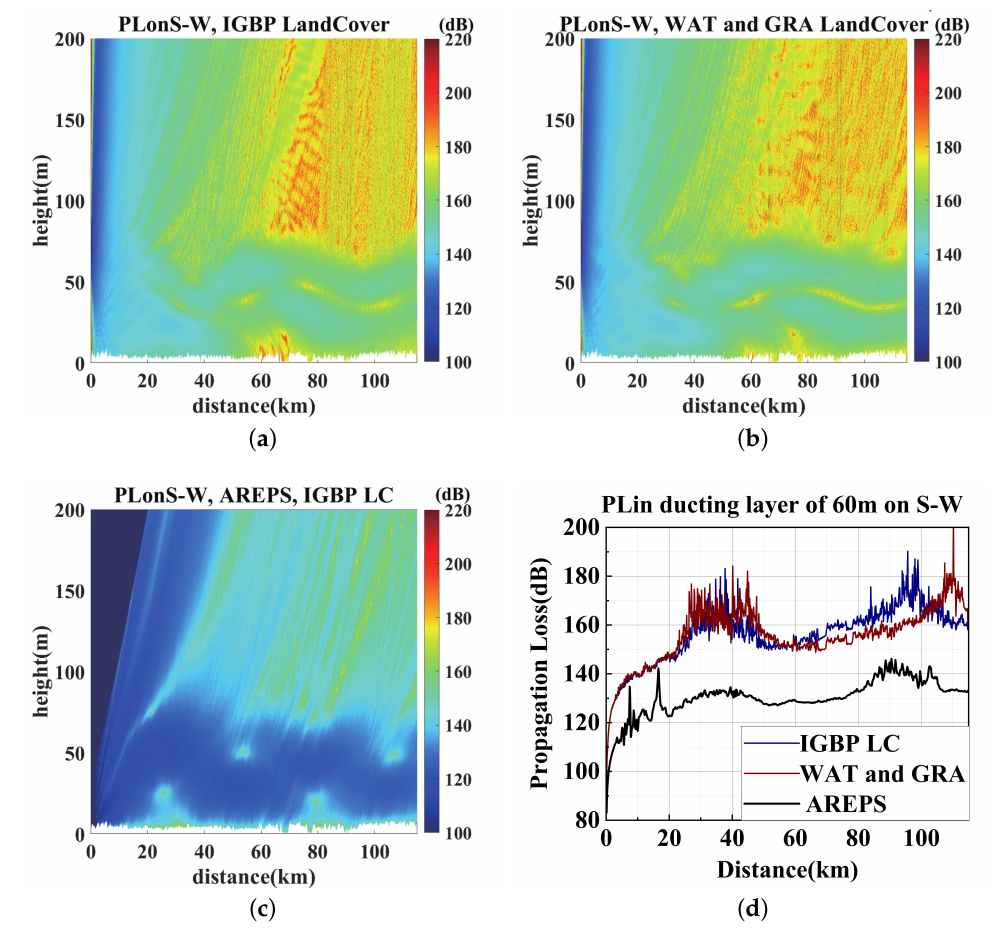
Figure 17. The propagation loss with tropospheric scattering, IGBP LC, and DEM considered on Shanghai–Wuxi. ( a ) PL from Shanghai–Wuxi using TPWE and IGBP LC. ( b ) PL from Shanghai–Wuxi using TPWE, WAT, and GRA LC. ( c ) PL from Shanghai–Wuxi using AREPS and IGBP LC. ( d ) PL at the duct-trapping layer of 60 m of different